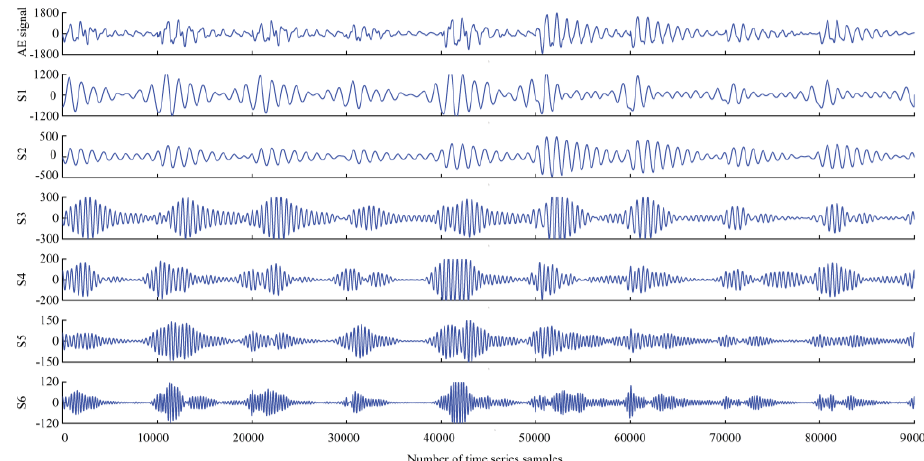
Figure 6. VMD algorithm decomposition results.